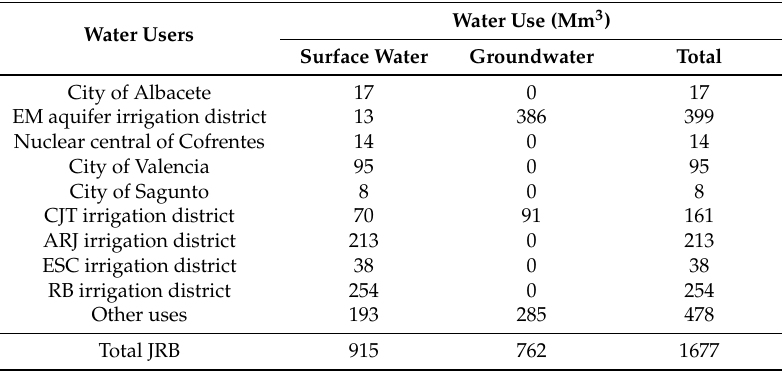
Table 2. The main water users in the JRB. Source. CHJ